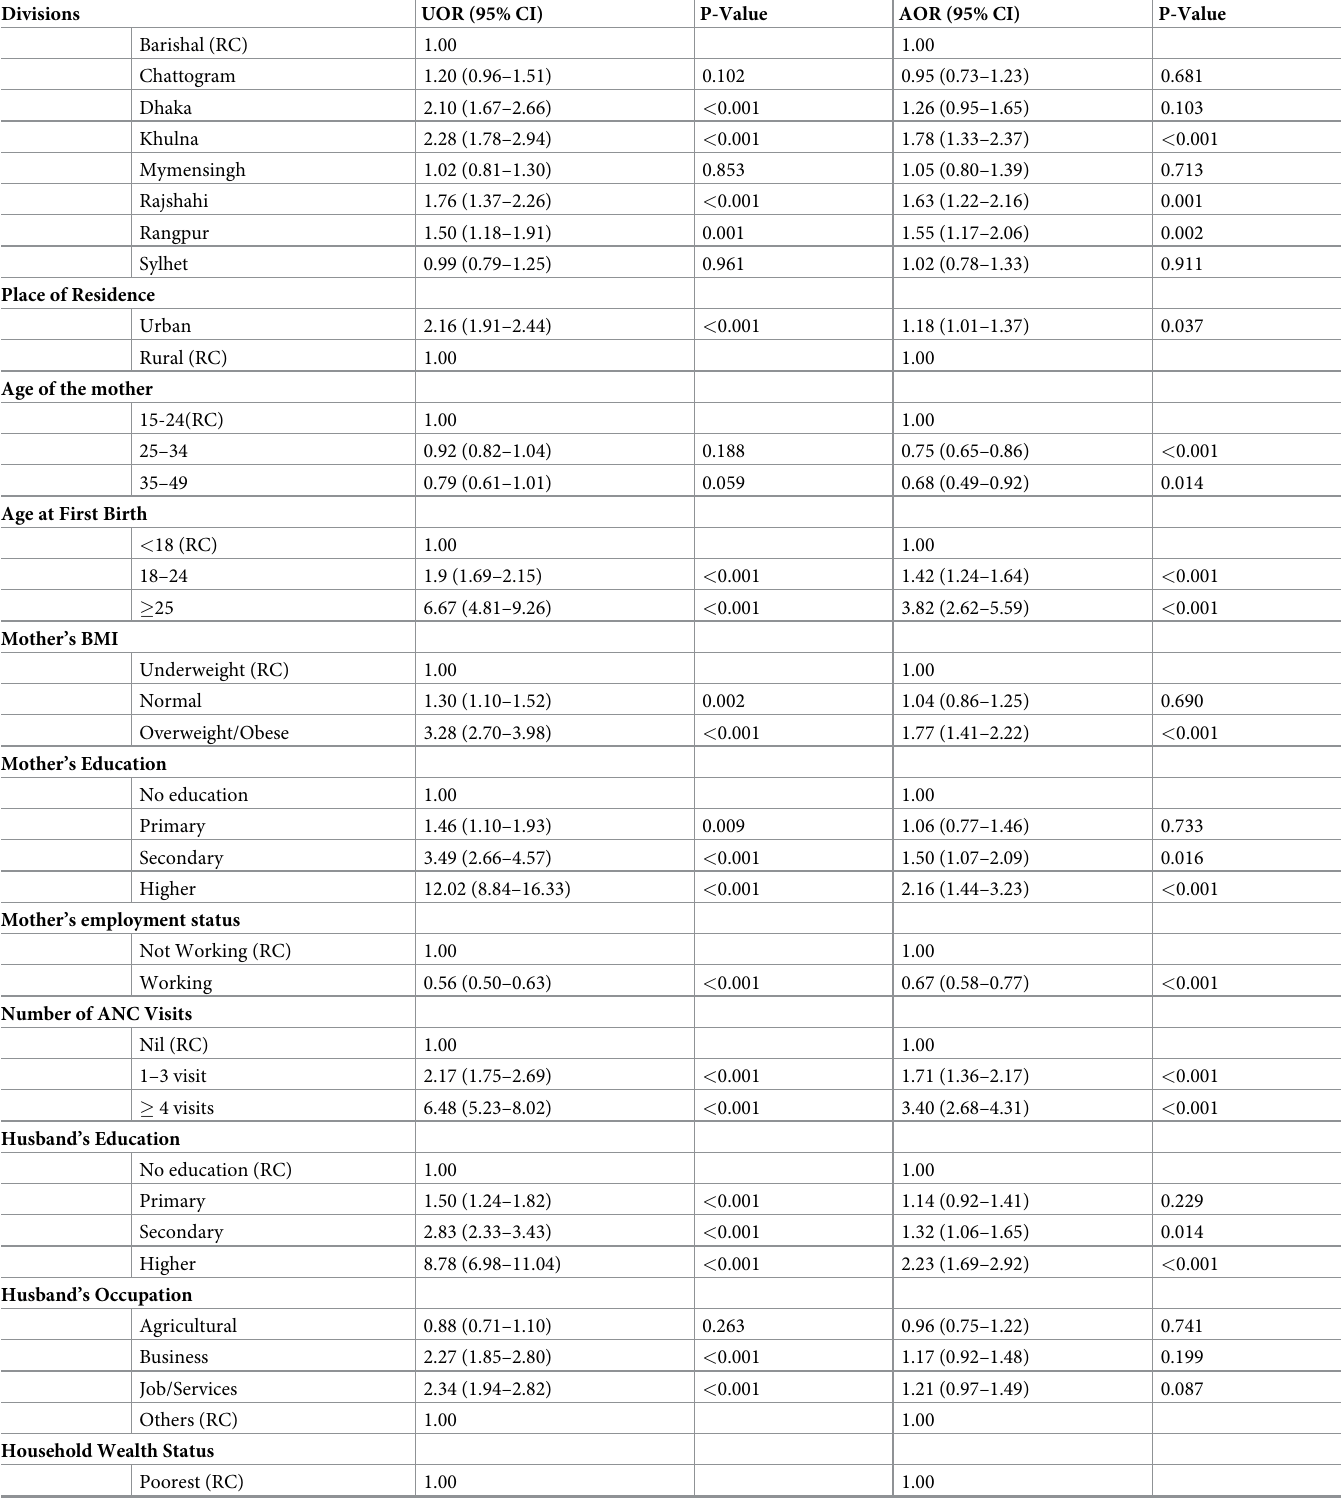
Table 4. Regression results factors associated with facility birth: BDHS